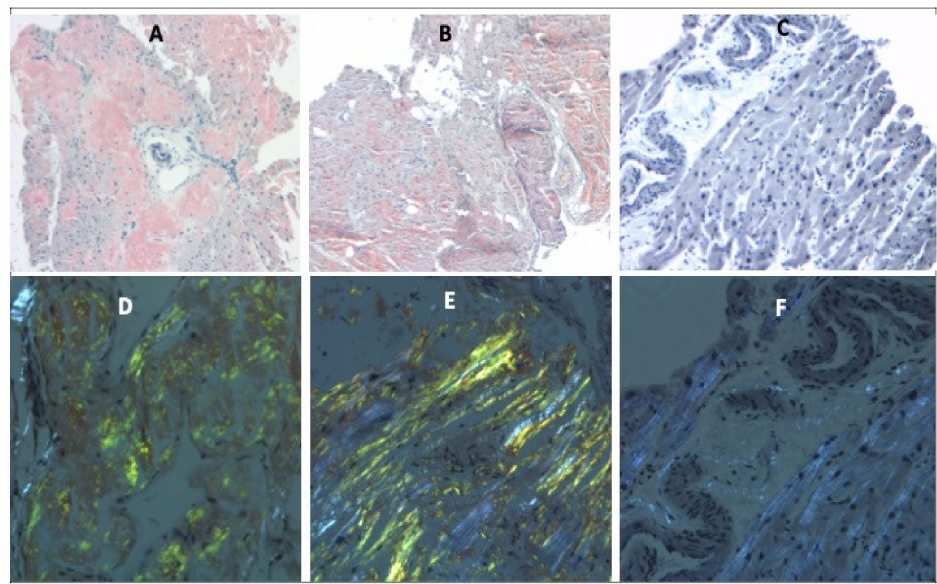
Figure 1. Bright field microscopy ( A – C ) and polarized light ( D – F ) display of Congo red-stained myocardial sections. Amyloid deposits are orange-red on Congo red staining with bright field microscopy and display apple-green birefringence under polarized light. ( A , D ) ATTR amyloid, ( B , E ) AL amyloid, and ( C , F ) Control myocardium.